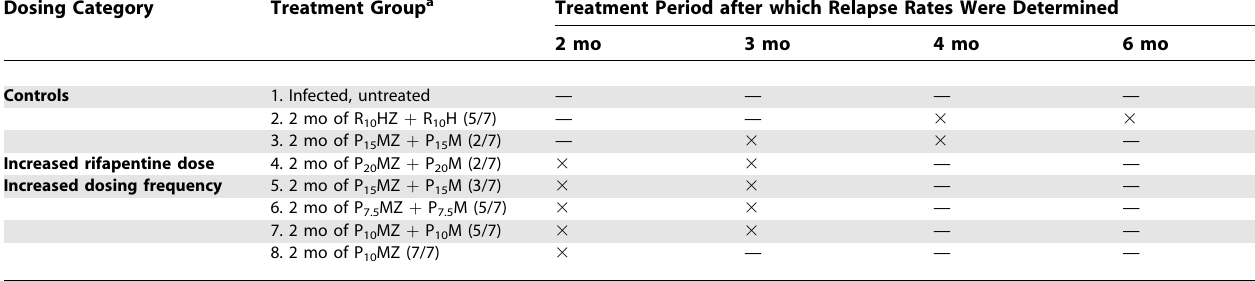
Table 1. Scheme of Chemotherapy Experiment Dosing Category Treatment Group a